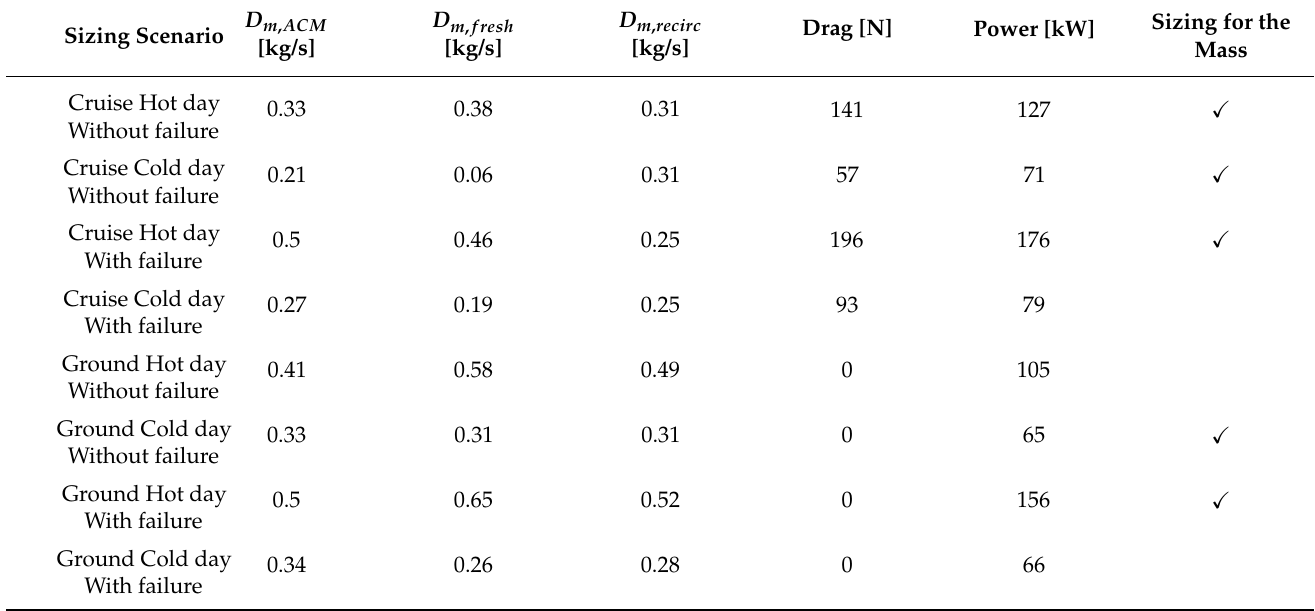
Table 1. Main results of ECS sizing for the sizing